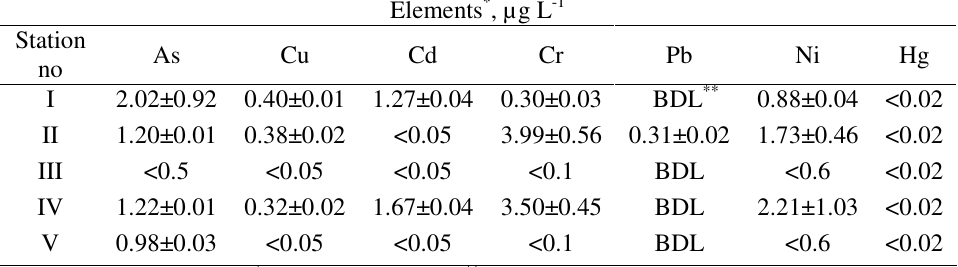
Table 2. Heavy metal content of the drinking water samples from Tunceli, Turkey Elements * , µg L